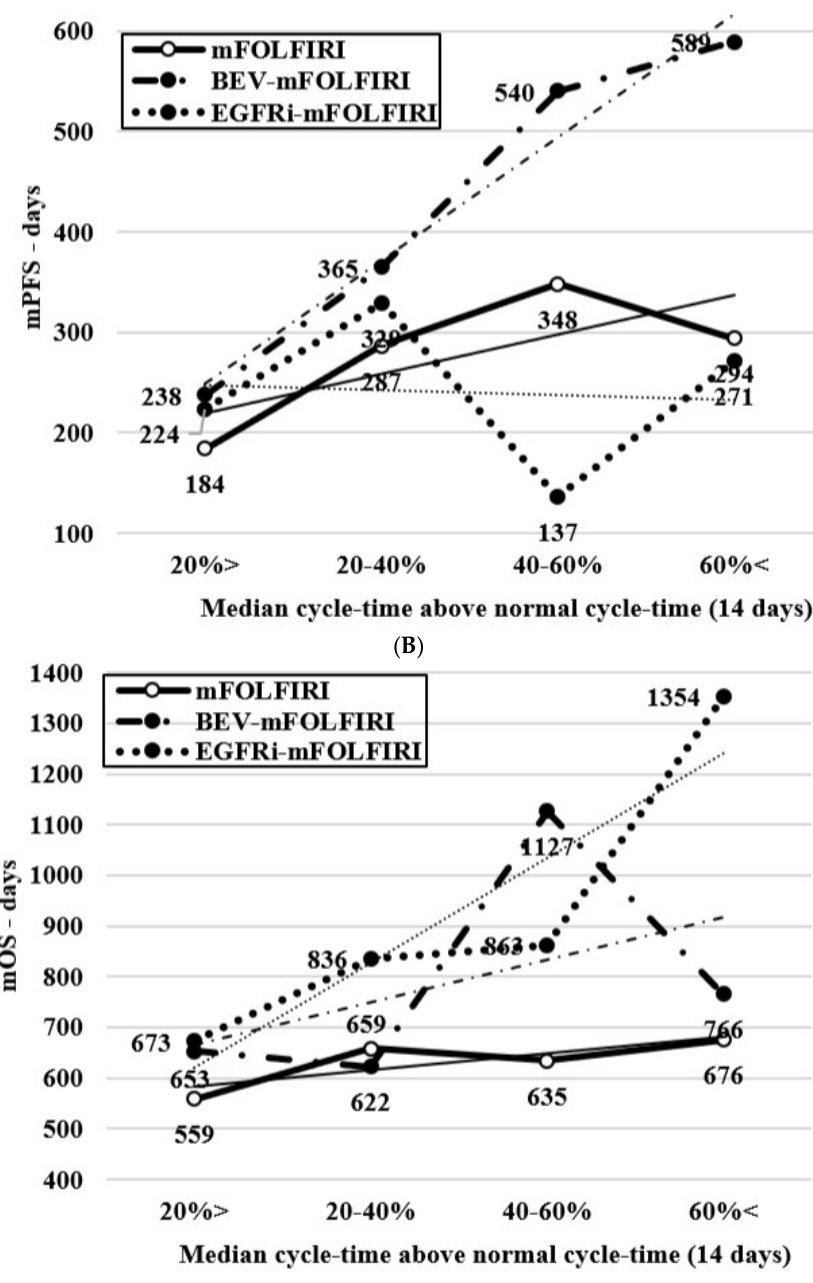
Figure 2. ( A ) mToT, ( B ) mPFS, and ( C ) mOS changes and trend lines according to the rate of deviation of cycle-time (incremental cycle-time groups of 20% relative to normal) by chemotherapy subgroups and trend lines.